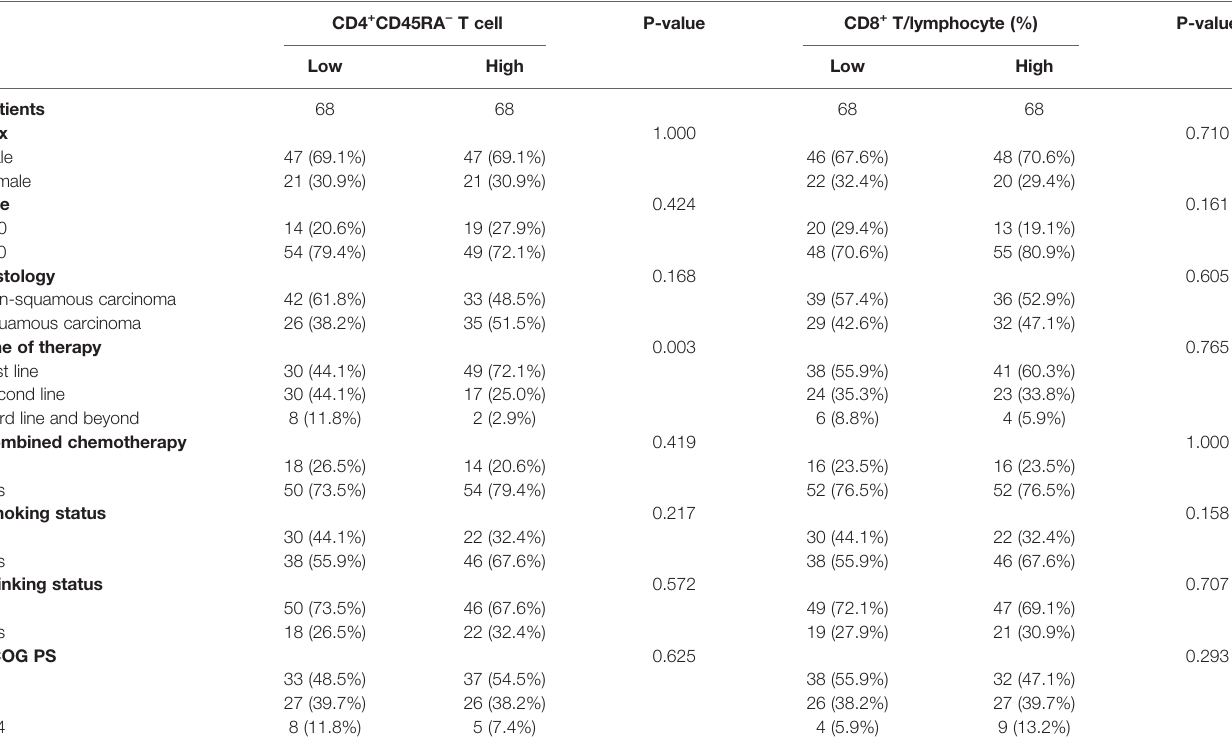
TABLE 4 | Basic information matching